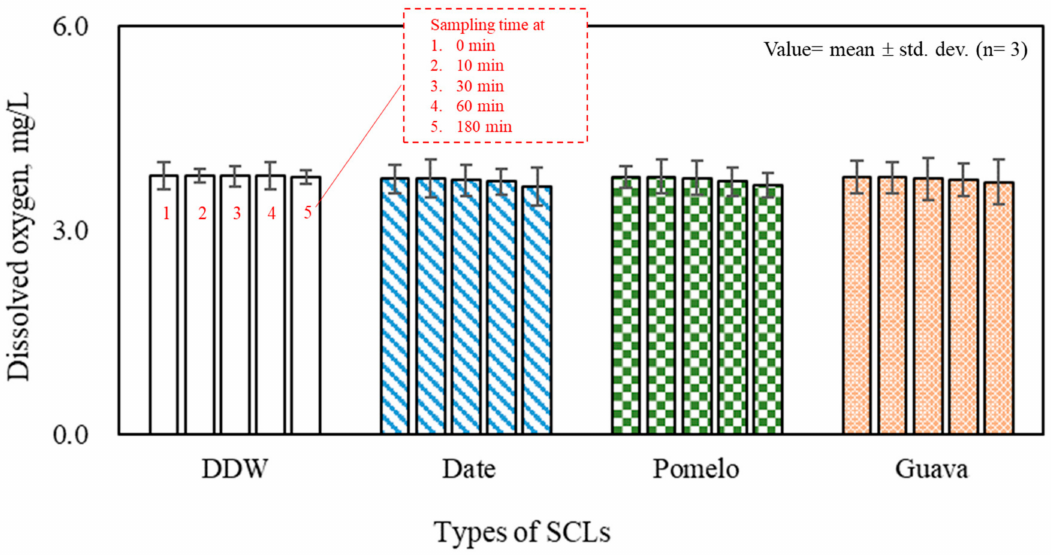
Figure 10. Plot of residual DOs in the liquid applied with various SCLs after 0–180 min. DDW was also applied and served as the control